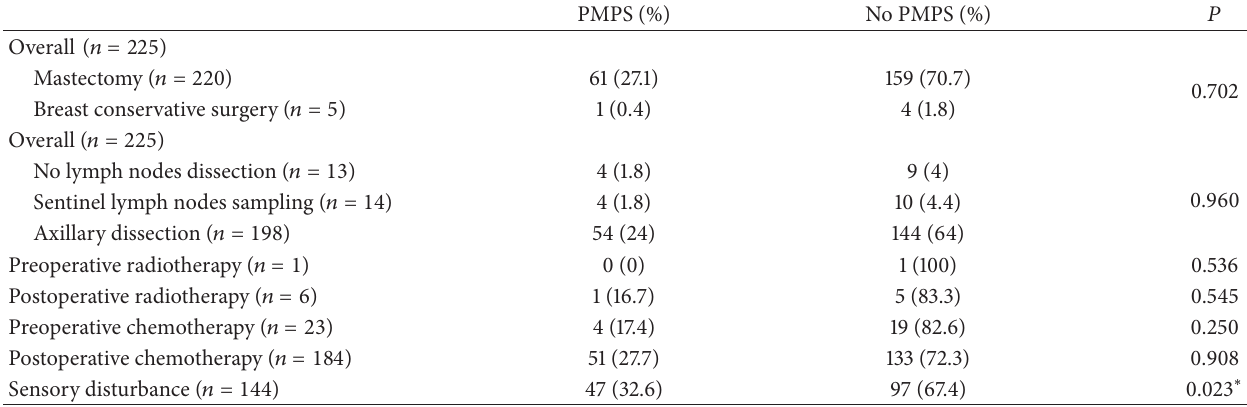
Table 3: Risk factors for